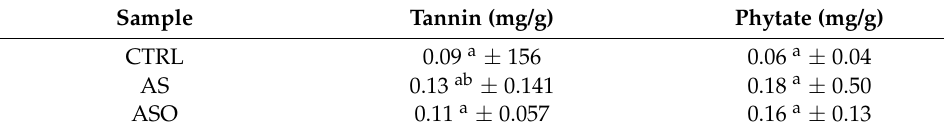
Table 5. Anti-nutritional content of the fermented complementary food.